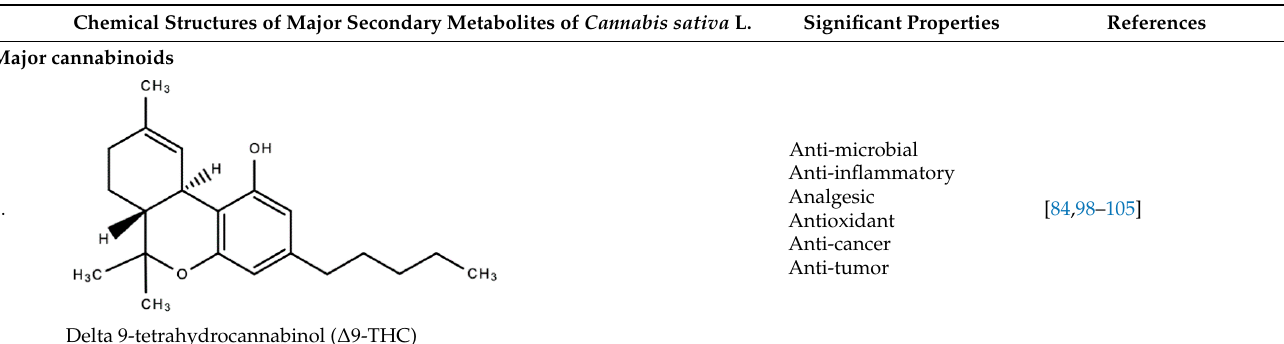
Table 3. Chemical structures of the major secondary metabolites (cannabinoids, terpenes and flavonoids) of Cannabis sativa L. with potent properties that may make them useful in the treatment of oral and dental diseases. Chemical Structures of Major Secondary Metabolites of Cannabis sativa